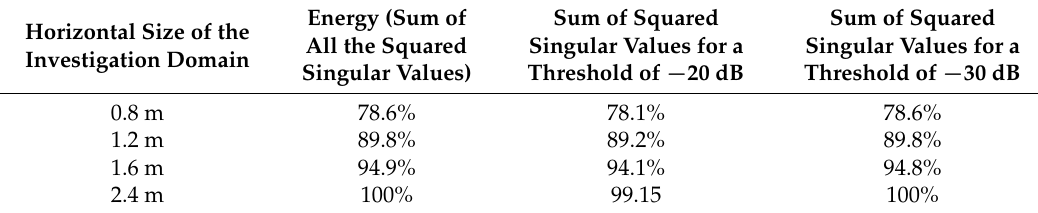
Table 1. Normalised energy (see Equation (6)) for four cases. Column 2 represents all the singular values. Column 3 represents singular values larger than − 20 dB. Column 4 represents singular values larger than − 30 dB.